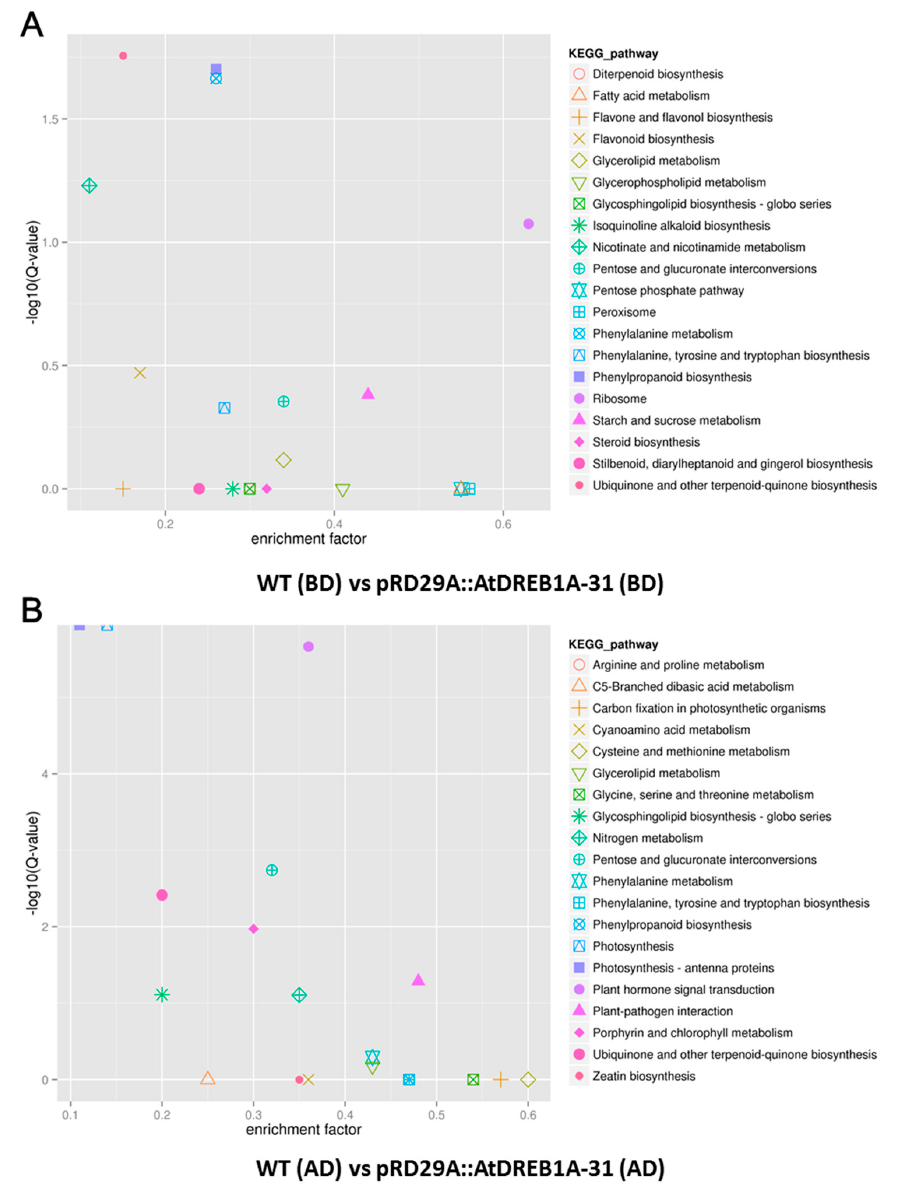
Figure 6. Scatter plot of KEGG pathways enriched in the comparisons of WT and AtDREB1A transgenic plants before and after drought treatment. ( A ) WT (BD) versus pRD29A::AtDREB1A-31 (BD); ( B ) WT (AD) versus pRD29A::AtDREB1A-31 (AD). WT, wild type; pRD29A::AtDREB1A-31, pRD29A::AtDREB1A transgenic line 31. BD, before drought; AD, after six days of drought.